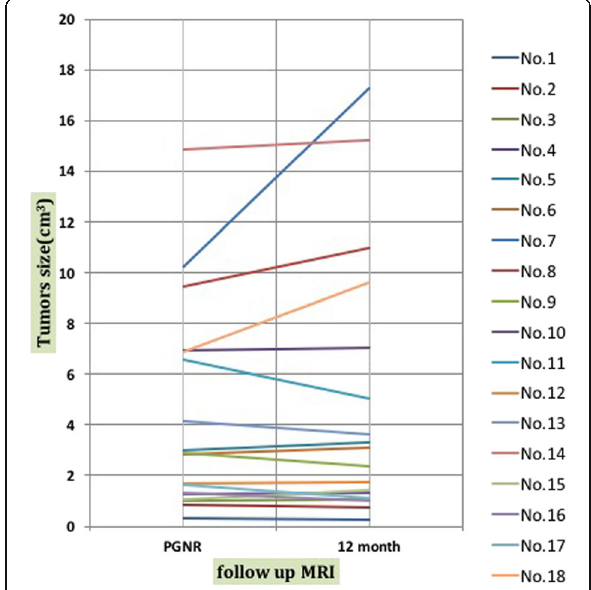
Fig. 5 Linear chart shows tumors volumetric changes after 12 months of